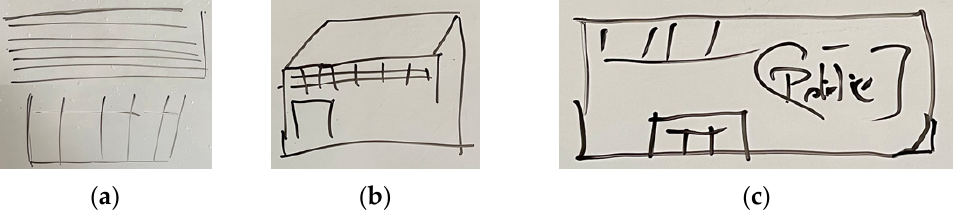
Figure 4. ( a ) Cognitive mapping from participant 1; ( b ) cognitive mapping from participant 2; ( c ) cognitive mapping from participant 3.